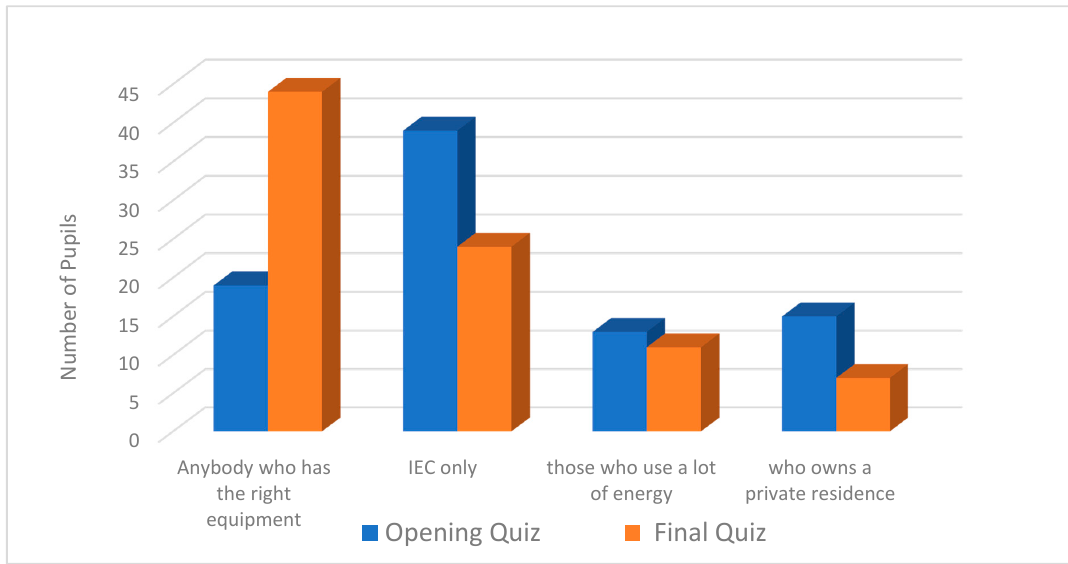
Figure 7. Results for the question “Who is capable of electricity generation?”.